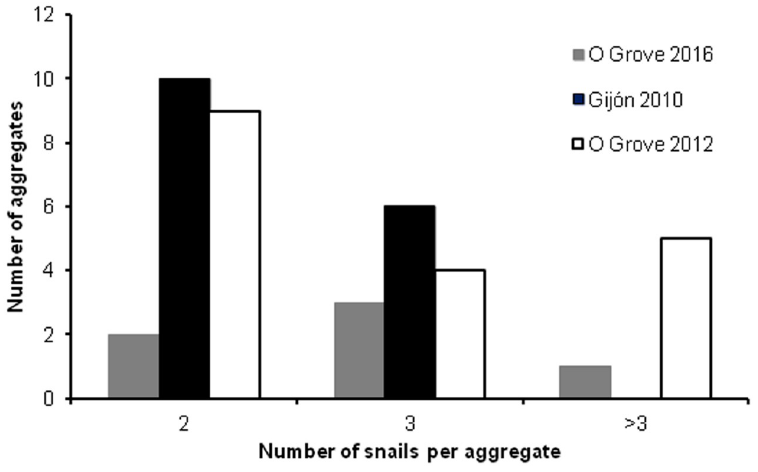
Fig 8. Frequency distribution of aggregate size in introduced populations of C . dilatata .